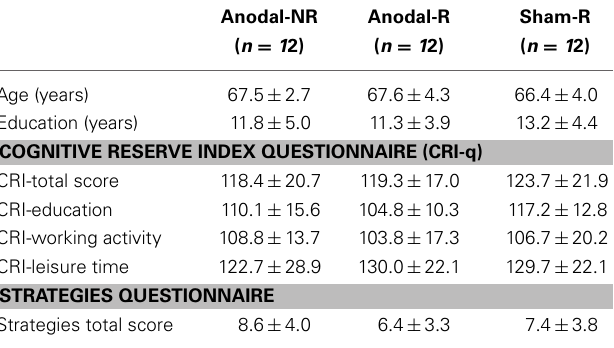
Table 1 | Demographic characteristics of older individuals grouped according to the experimental conditions (Anodal-NR; Anodal-R; Sham-R), and Cognitive Reserve Index (CRI-q) and strategies questionnaire